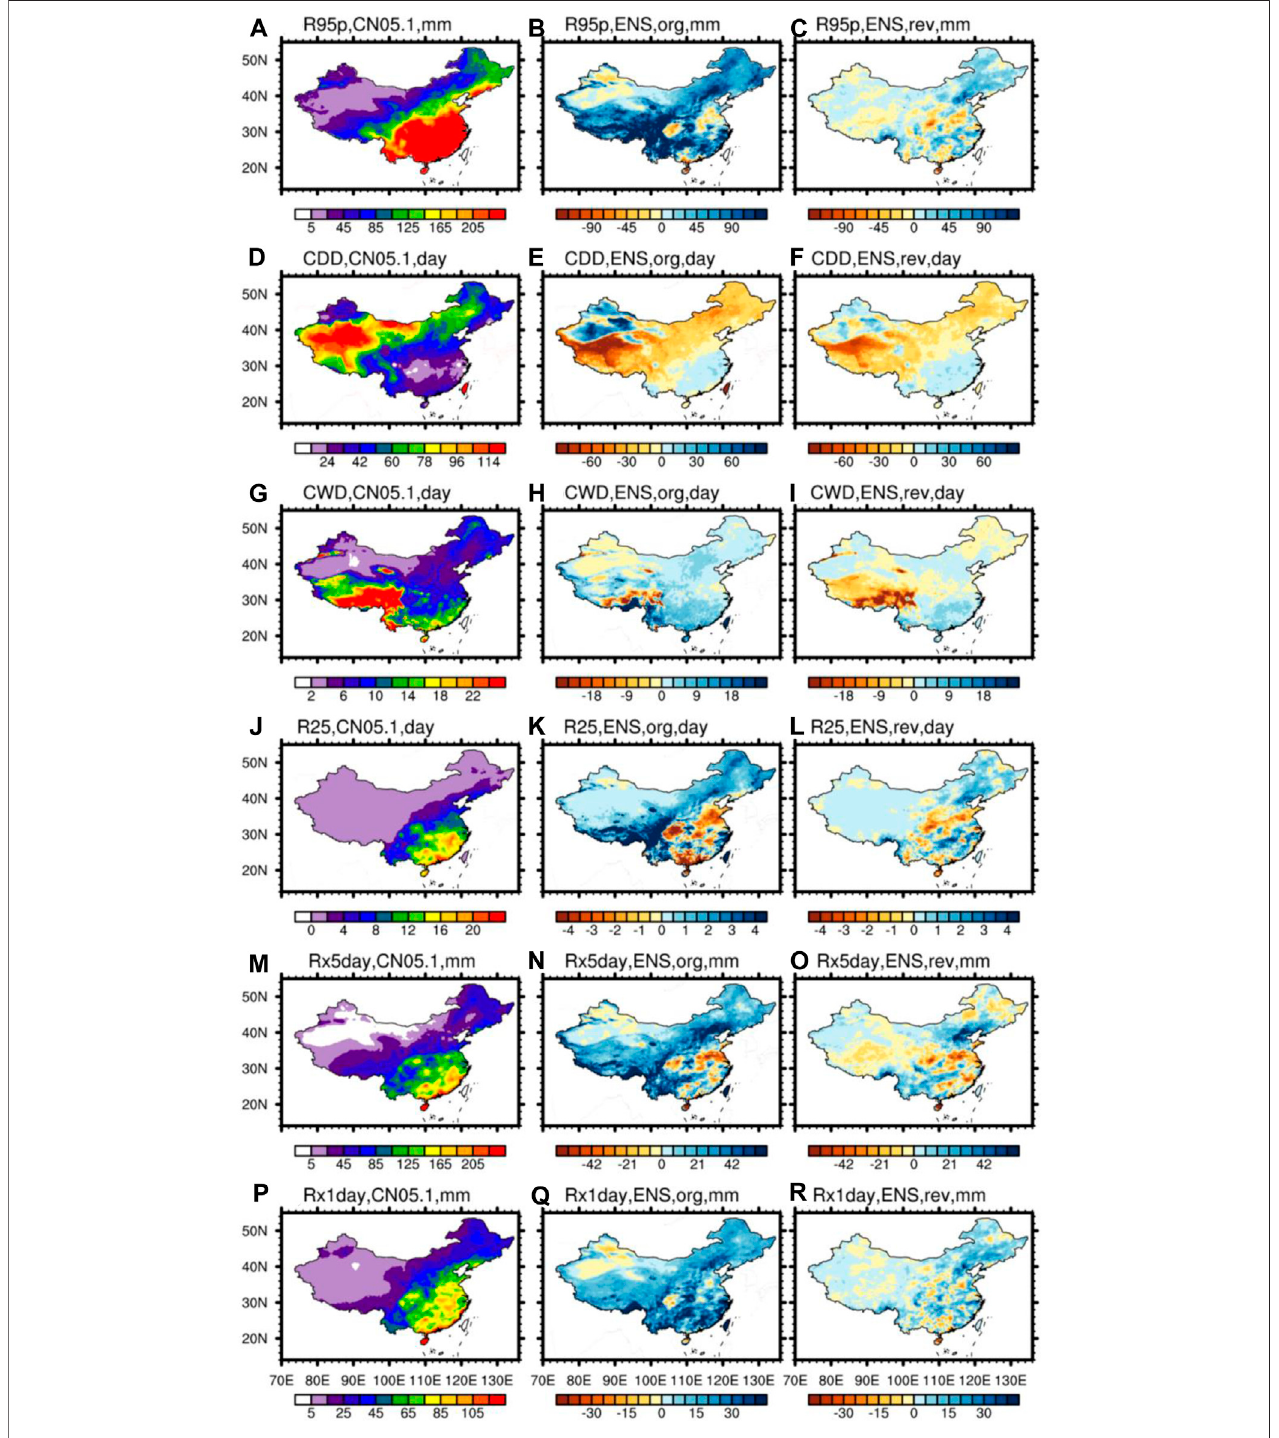
FIGURE5| Sameas Figure4 ,butfortheextremeprecipitationindexesoftheR95p (A – C) ,theCDD (D – F) ,theCWD (G – I) ,theR25 (J – L) ,theRx5day (M – O) ,and the Rx1day (P – R) .